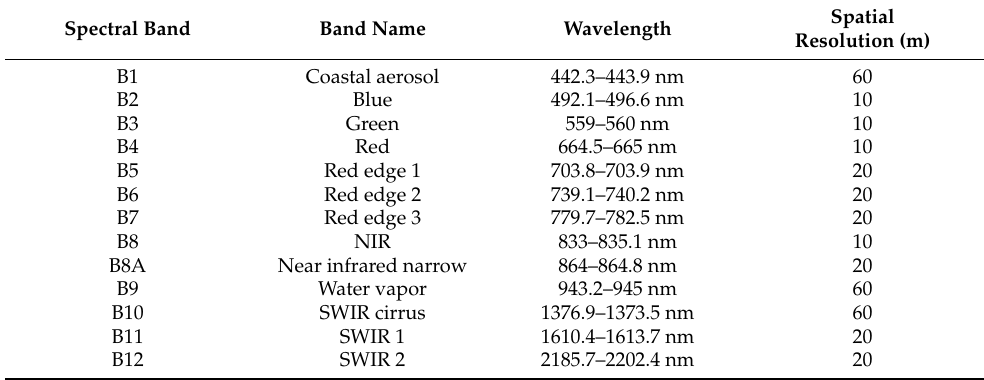
Table 2. Spectral bands of the Sentinel-2 imagery.